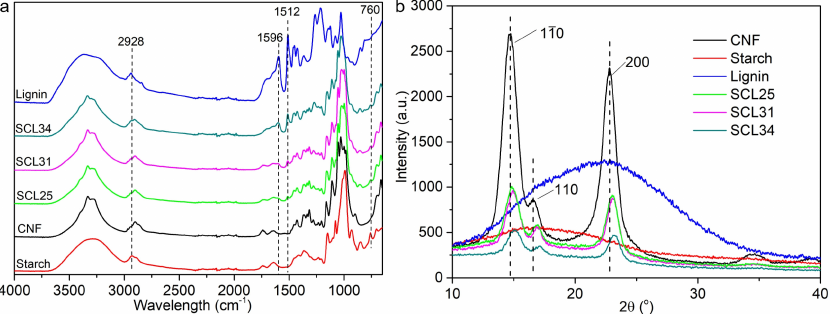
Figure 2. Fourier transform infrared (FTIR) ( a ) and X-ray diffraction (XRD) ( b ) spectra of starch, CNF, lignin and composite